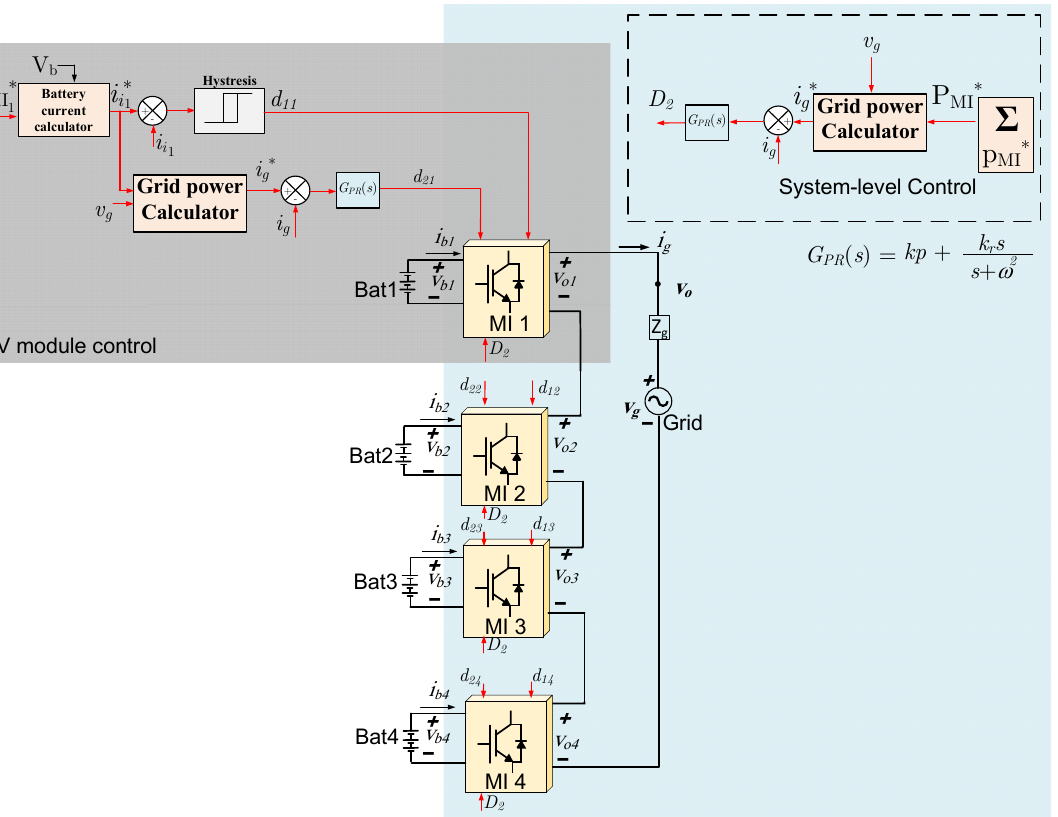
Figure 20. PV module and system-level controllers for battery/grid DC/AC inversion.